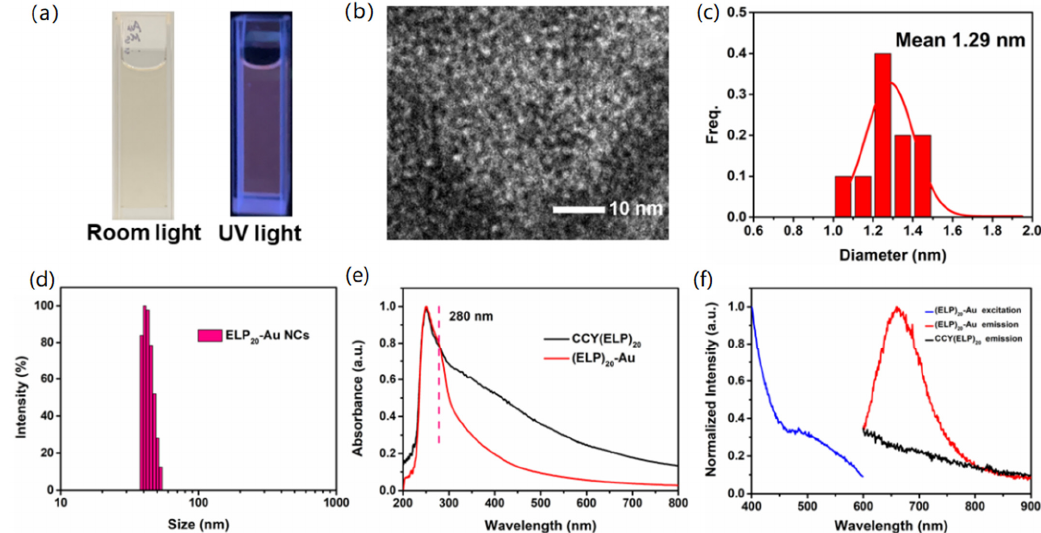
Figure 3. Characterizations of (ELP) 20 - Au NCs. ( a ) Photographs of (ELP) 20 - Au NCs under room light and UV light. ( b ) Negative-stain EM image of the (ELP) 20 - Au NCs. ( c ) The histogram of diameter distribution of the (ELP) 20 - Au NCs. ( d ) Hydrodynamic diameter distribution of the (ELP) 20 - Au NCs. ( e ) UV-Vis spectra of CCY(ELP) 20 and (ELP) 20 - Au NCs. ( f ) Fluorescence excitation (blue) and emission spectra of (ELP) 20 - Au NCs (red) and CCY(ELP) 20 (black).